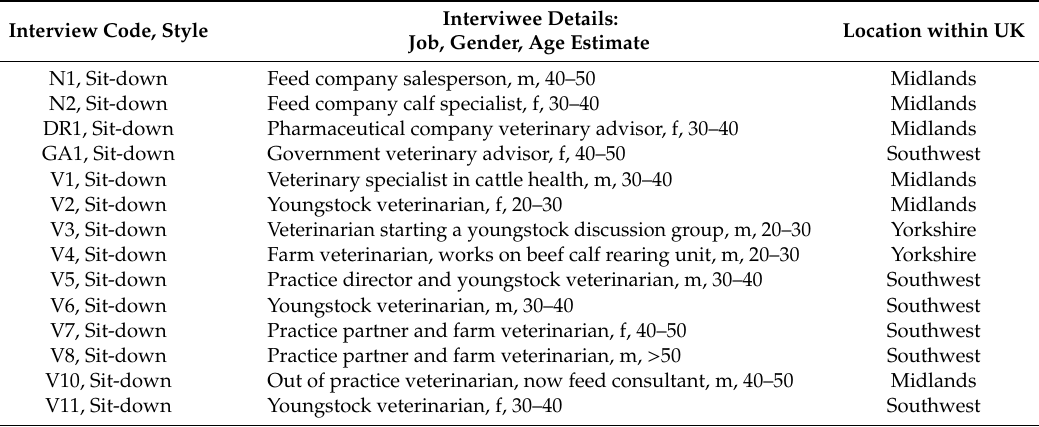
Table 2. Advisor participant